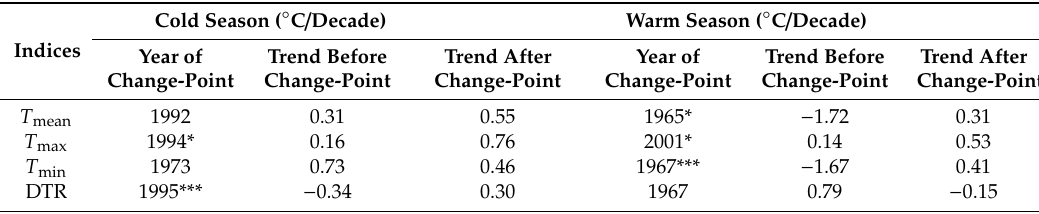
Table 2. Change-point analysis of four temperature indices during the cold and warm seasons on the mid-south of Tibetan Plateau on the period of 1961 −